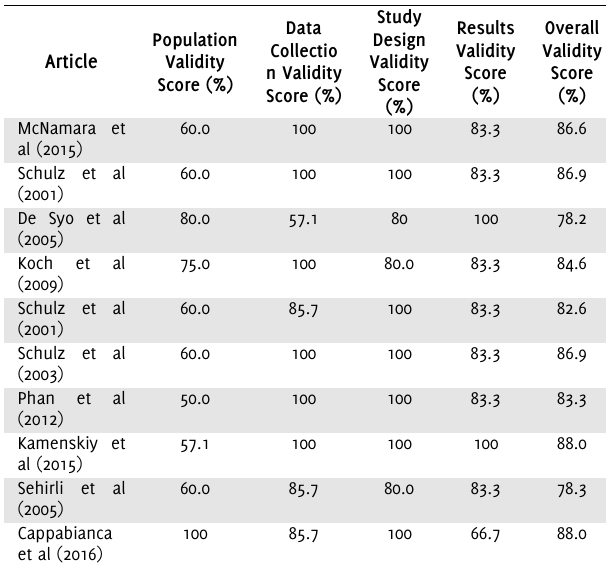
Table 4 . Critical appraisal and selection score of reviewed articles based on the EBL critical appraisal